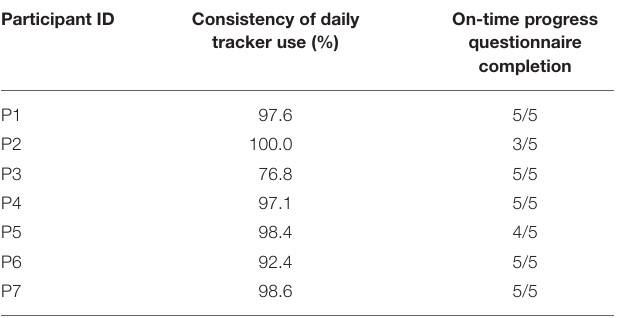
TABLE 3 | End of project patient satisfaction questionnaire